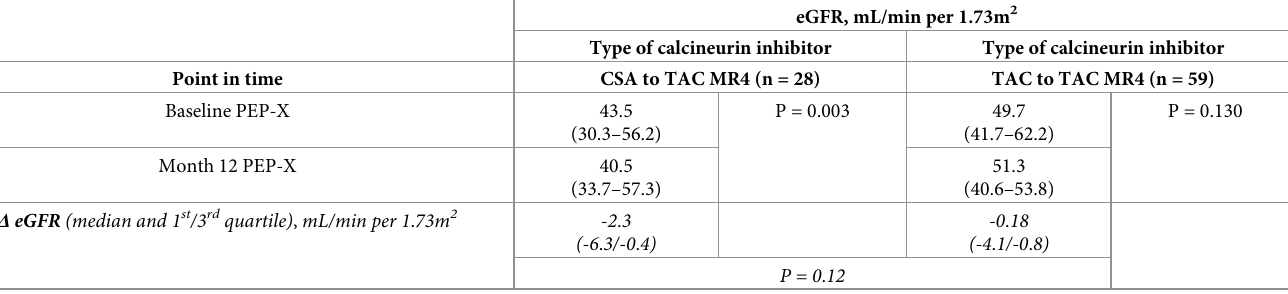
Table 2. Glomerular filtration rate and median change of eGFR of 87 kidney transplant recipients after conversion from either ciclosporin (n = 28) or tacrolimus (n = 59) to tacrolimus modified release over 12